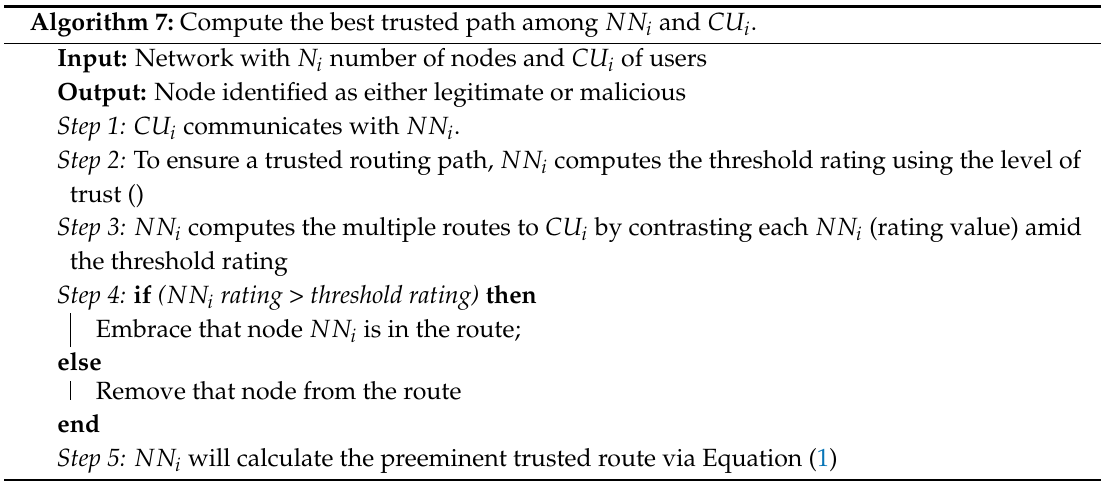
Algorithm 7: Compute the best trusted path among NN i and CU i .